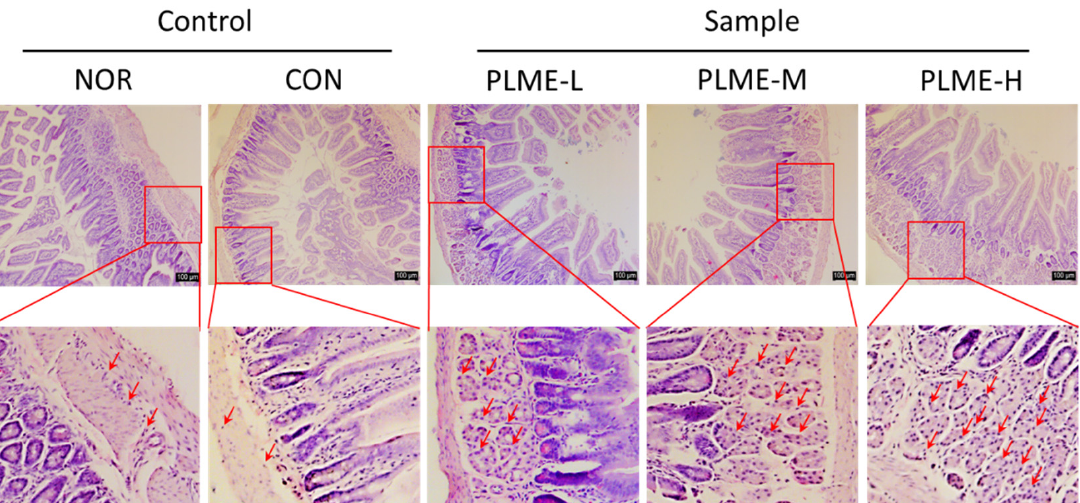
Figure 6. Histomorphometric analysis of small intestinal tissue in mice administered with PLME for four weeks. Tissue biopsies of small intestines were stained with H & E and observed on the microscopy (magnification ×200). Scale bar = 100 μ m. Red arrows indicate recruited lymphocytes at the submucosa and muscularis externa areas. NOR, normal group administered tap water; CON, medium control group administered only culture medium (250 mg/kg/day); PLME-L, PLME-M, and PLME-H, sample groups administered postbiotics prepared from P. linteus mycelial submerged culture at doses of 250, 500, and 1000 mg/kg bw/day, respectively.